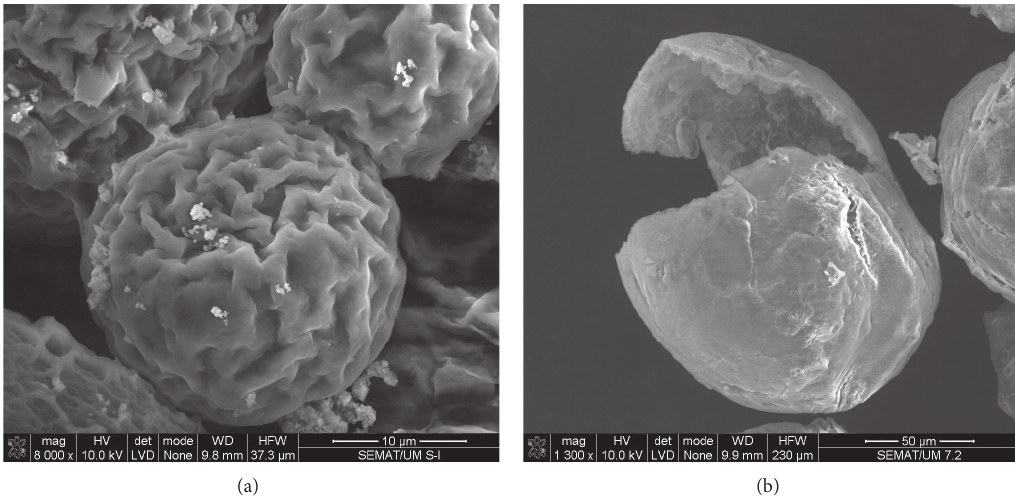
Figure 8: Scanning electron microscopy micrographs of dodecane-loaded polyamide microcapsules (a) with N-doped TiO 2 nanoparticles adsorbed onto its surface and (b) microcapsule degradation upon UV-A